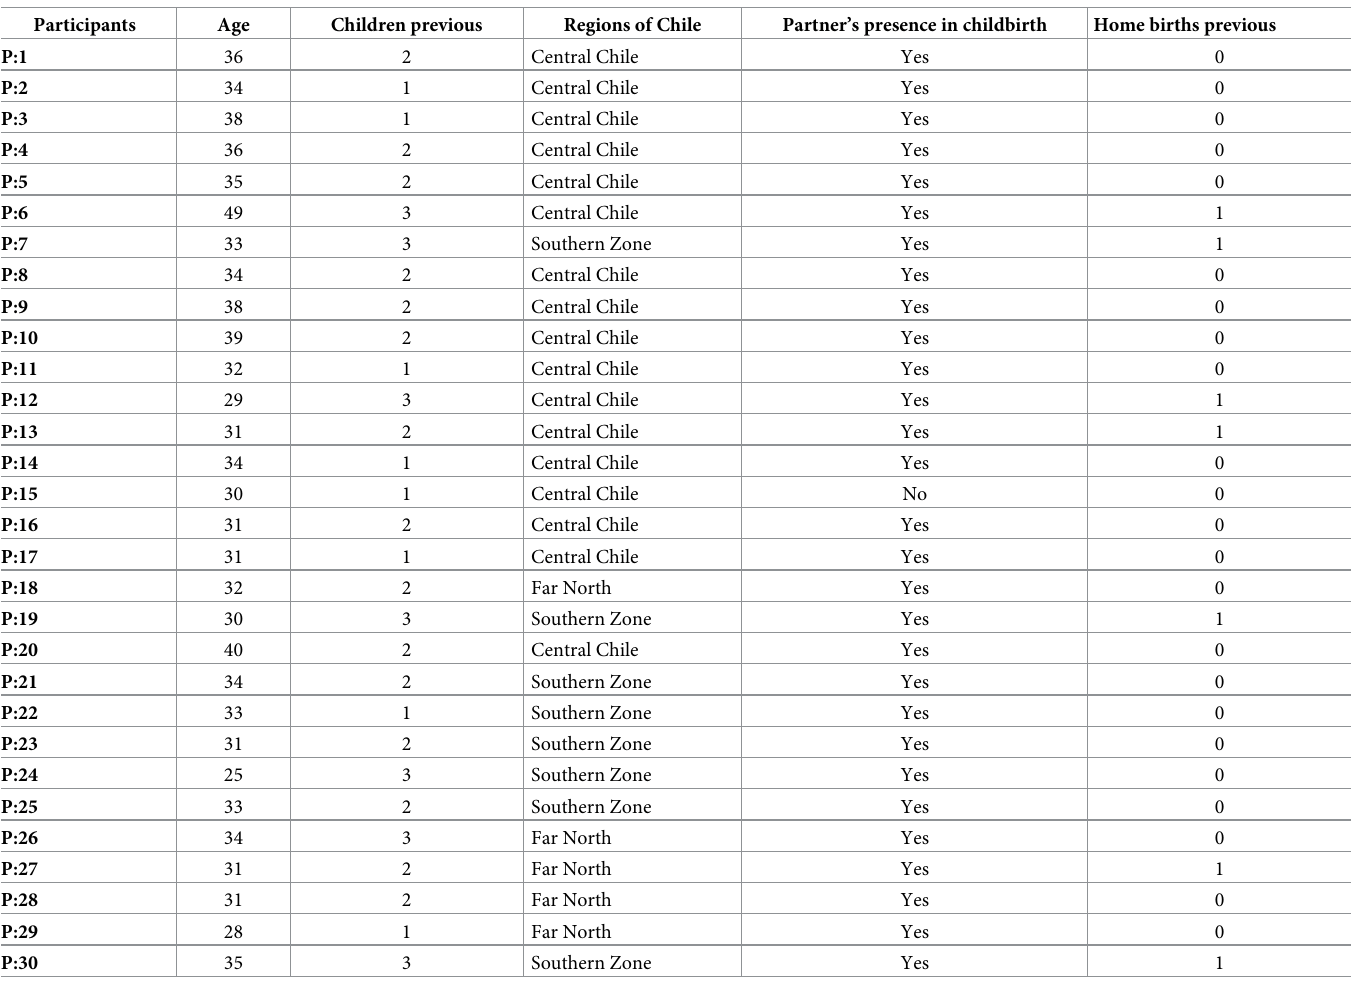
Table 1. Participant